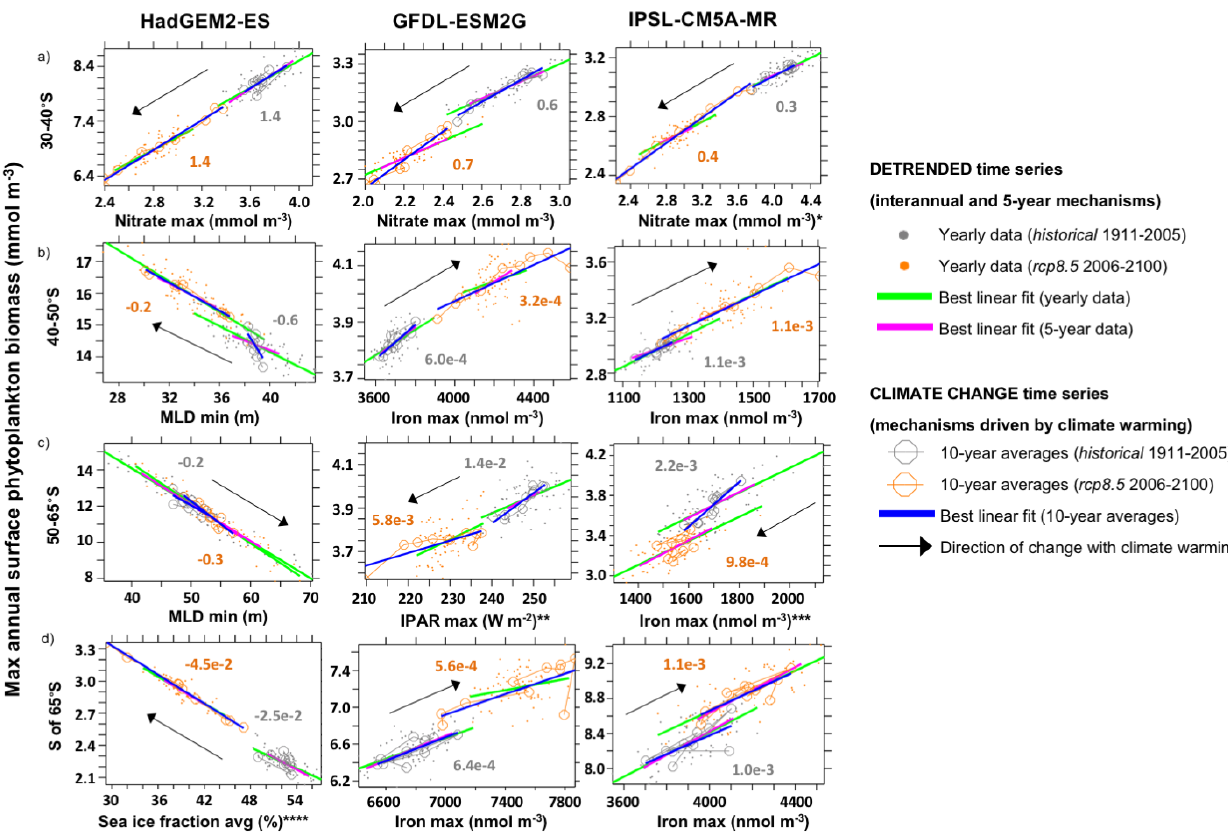
Figure 2. Drivers of phytoplankton biomass on multiple timescales. Scatter plots of PB versus the listed variable on interannual and 5- year (both with their climate change signals removed) as well as 10-year timescales. Each column corresponds to a different model, while each row corresponds to a different zonal band. Slopes of the historical and rcp8.5 10-year average best-fit lines are listed. Only variables with significant ( p < 0 . 05) best-fit lines on at least two out of the three timescales studied (interannual, 5-year, and 10-year) are shown. Best-fit lines are drawn only when correlations are significant ( p < 0 . 05). Variables tested are all those listed in Table 2. ∗ Wintertime MLD was also significant on all three timescales. ∗∗ Summertime MLD and avg annual cloud cover were also significant on all three timescales. ∗∗∗ Wintertime MLD was also significant on all three timescales. ∗∗∗∗ The y axis here is PP (µmolm − 2 s − 1 ) instead of PB because no variables were significantly correlated on at least two timescales with PB. Summertime IPAR was also significant on the same timescales as average annual sea ice